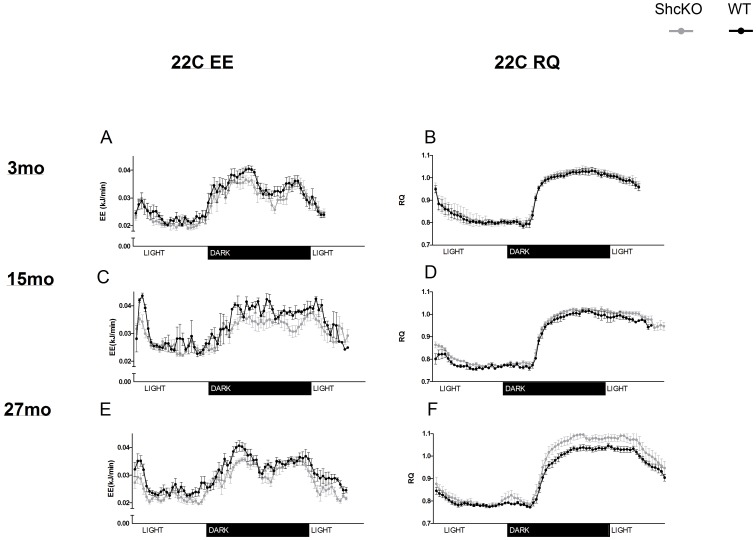
Energy expenditure (EE) and respiratory quotient (RQ) in ShcKO and wild-type (WT) mice housed at 22°C.Mean (±SEM) EE and RQ values collected over a 24 hour period in 3 mo (A&B), 15 mo (C&D), and 27 mo (E&F) mice. ShcKO = p66 Shc(−/−) mice, mo = months.